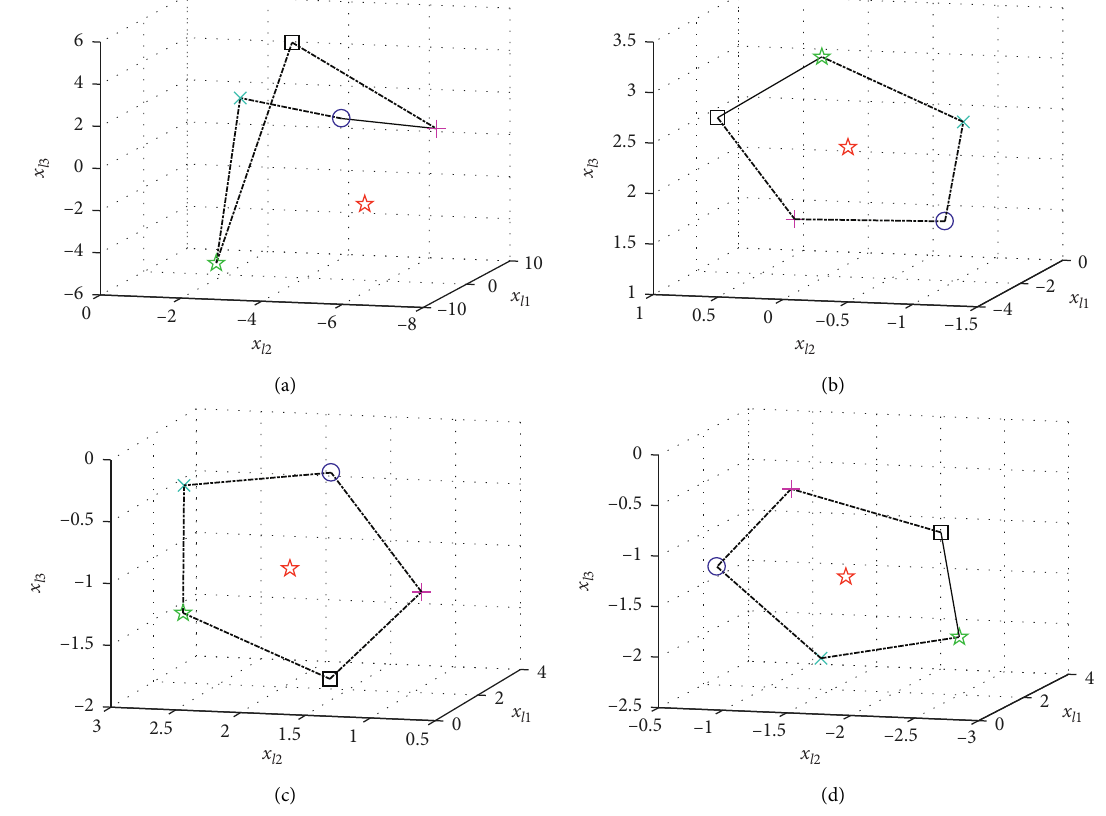
Figure 6: State snapshots of five followers and the leader at different times: (a) t � 0 s; (b) t � 8 s; (c) t � 9s; (d) t �